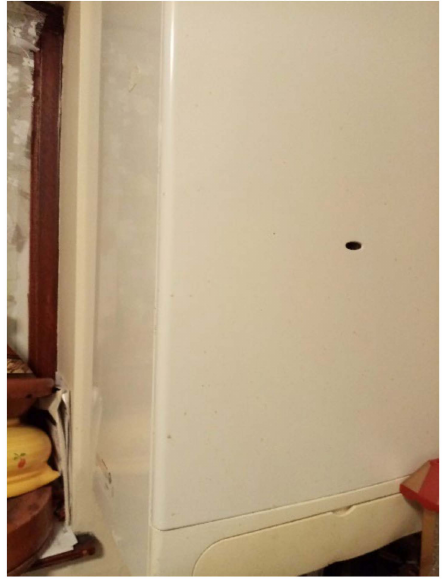
Figure 19. “Broken boiler. The boiler is not working”.